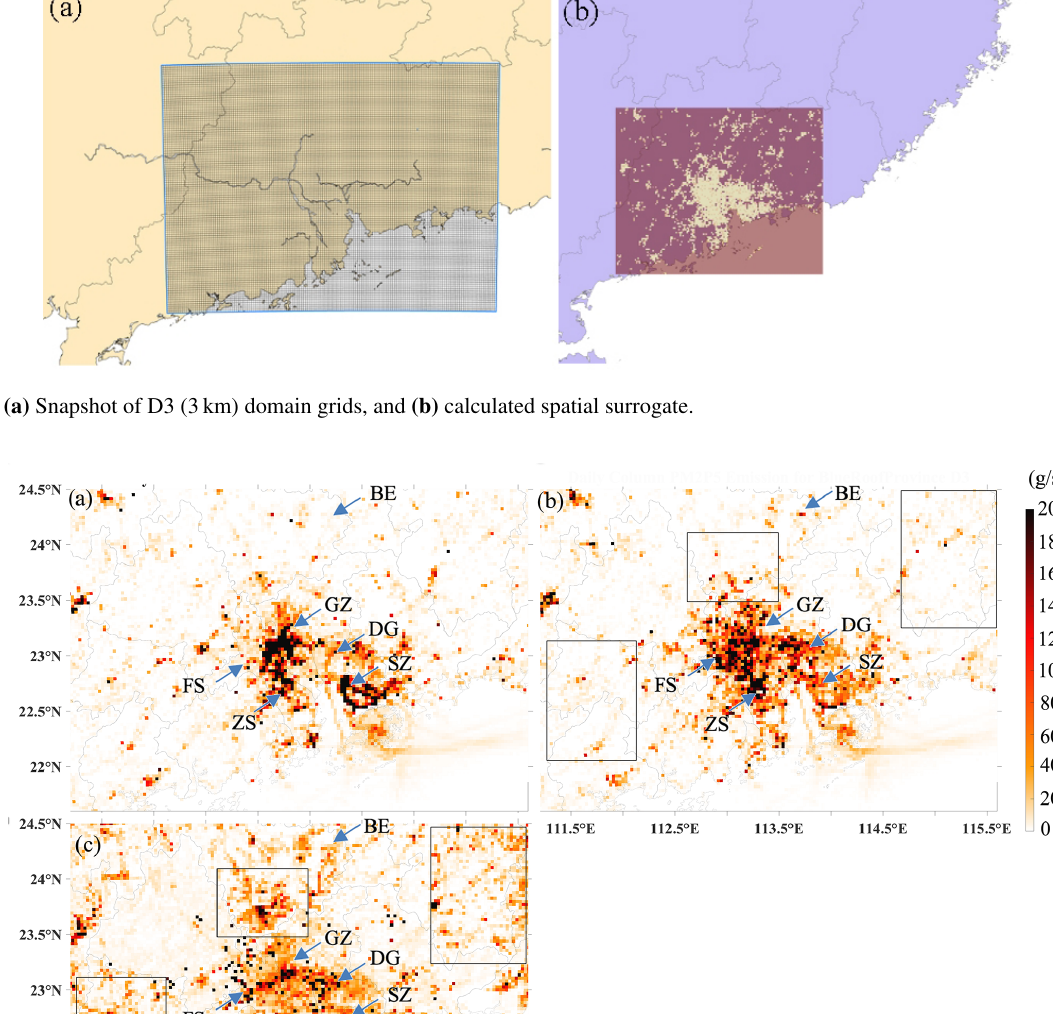
PM 2 . 5 time-series plot of Zhongshan station (22 ◦ 31 (cid:48) 16.0 (cid:48)(cid:48) N 113 ◦ 22 (cid:48) 36.8 (cid:48)(cid:48) E) shown in Fig. 7a) where the large PM 25 overestimation in the base case (grey line) was significantly reduced into the more acceptable range shown in the blue- roof case (blue line). The root mean square error (RMSE) was trimmed down by nearly half to about 23.0 µg m − 3 (from 49.2 µg m − 3 in the base case to 26.2 µg m − 3 in the blue-roof case), demonstrating the effectiveness of using the blue-roof allocation method in the top-down emission approach.